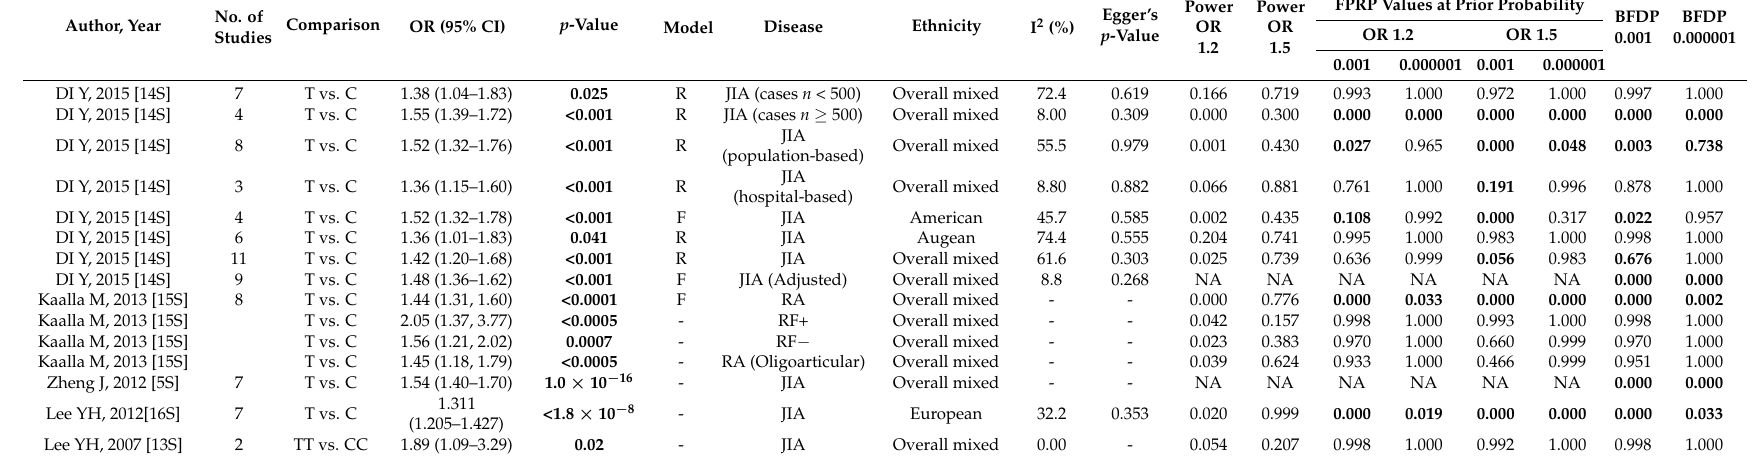
JIA, juvenile idiopathic arthritis; OR, odds ratio; R, random; F, fixed; S, supplementary; FPRP, false-positive report probability; BFDP, Bayesian false discovery probability. Each comparison of genetic associations was regarded as noteworthy when FPRP of <0.2 or BFDP of <0.8 or both are fulfilled and the values were bolded when the results are significant by FPRP or BFDP. NAs are expressed when information is not available by FPRP